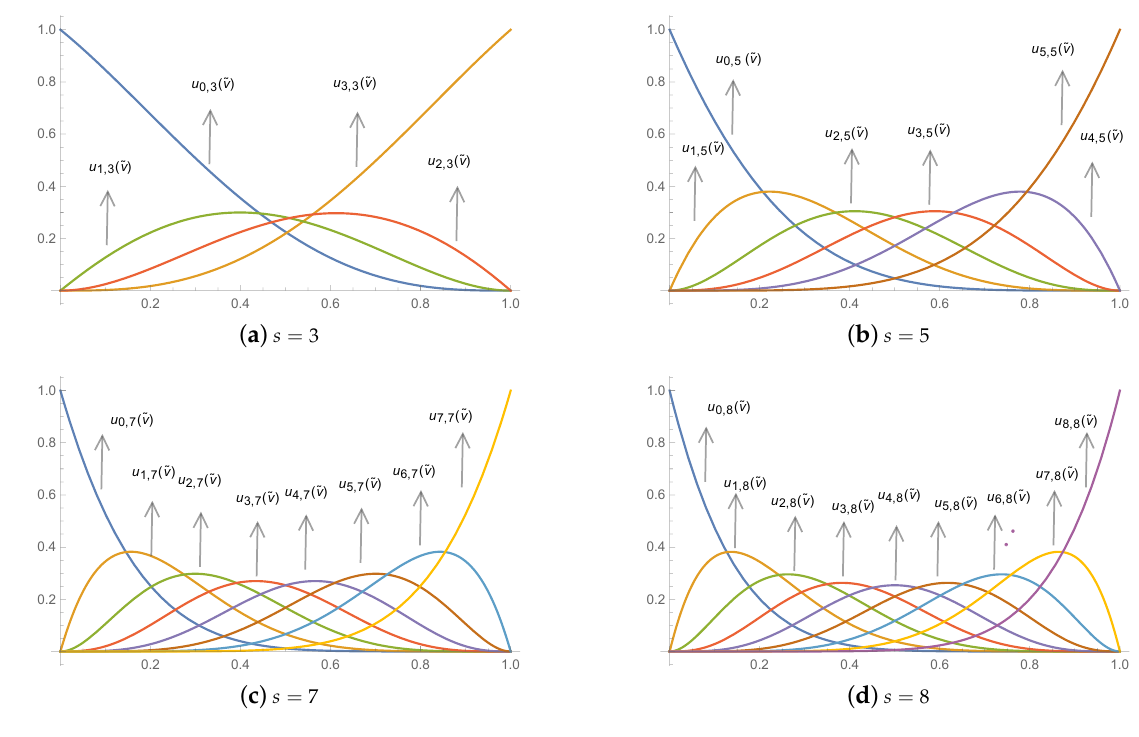
Figure 1. Bernstein-like basis functions with various degrees.